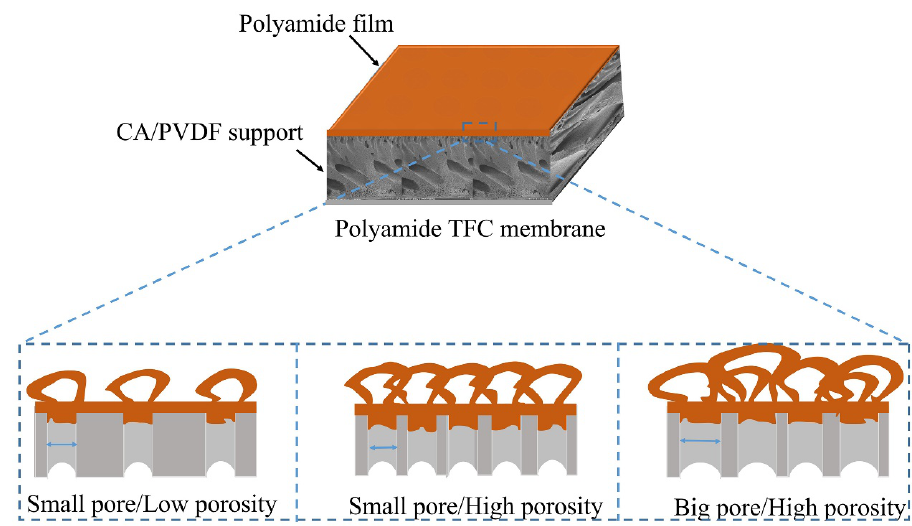
Figure 6. Schematic diagram of PA film formation on different supports.